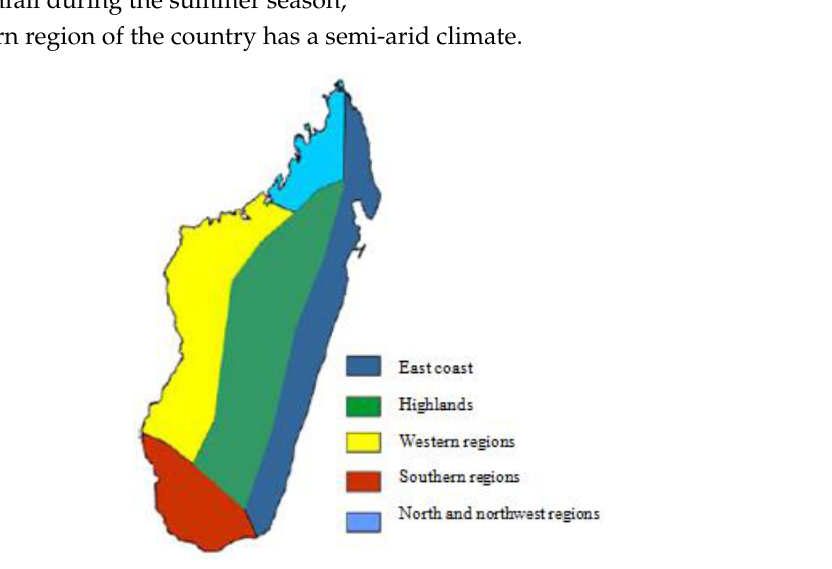
Figure 1. The five climate regions of Madagascar.